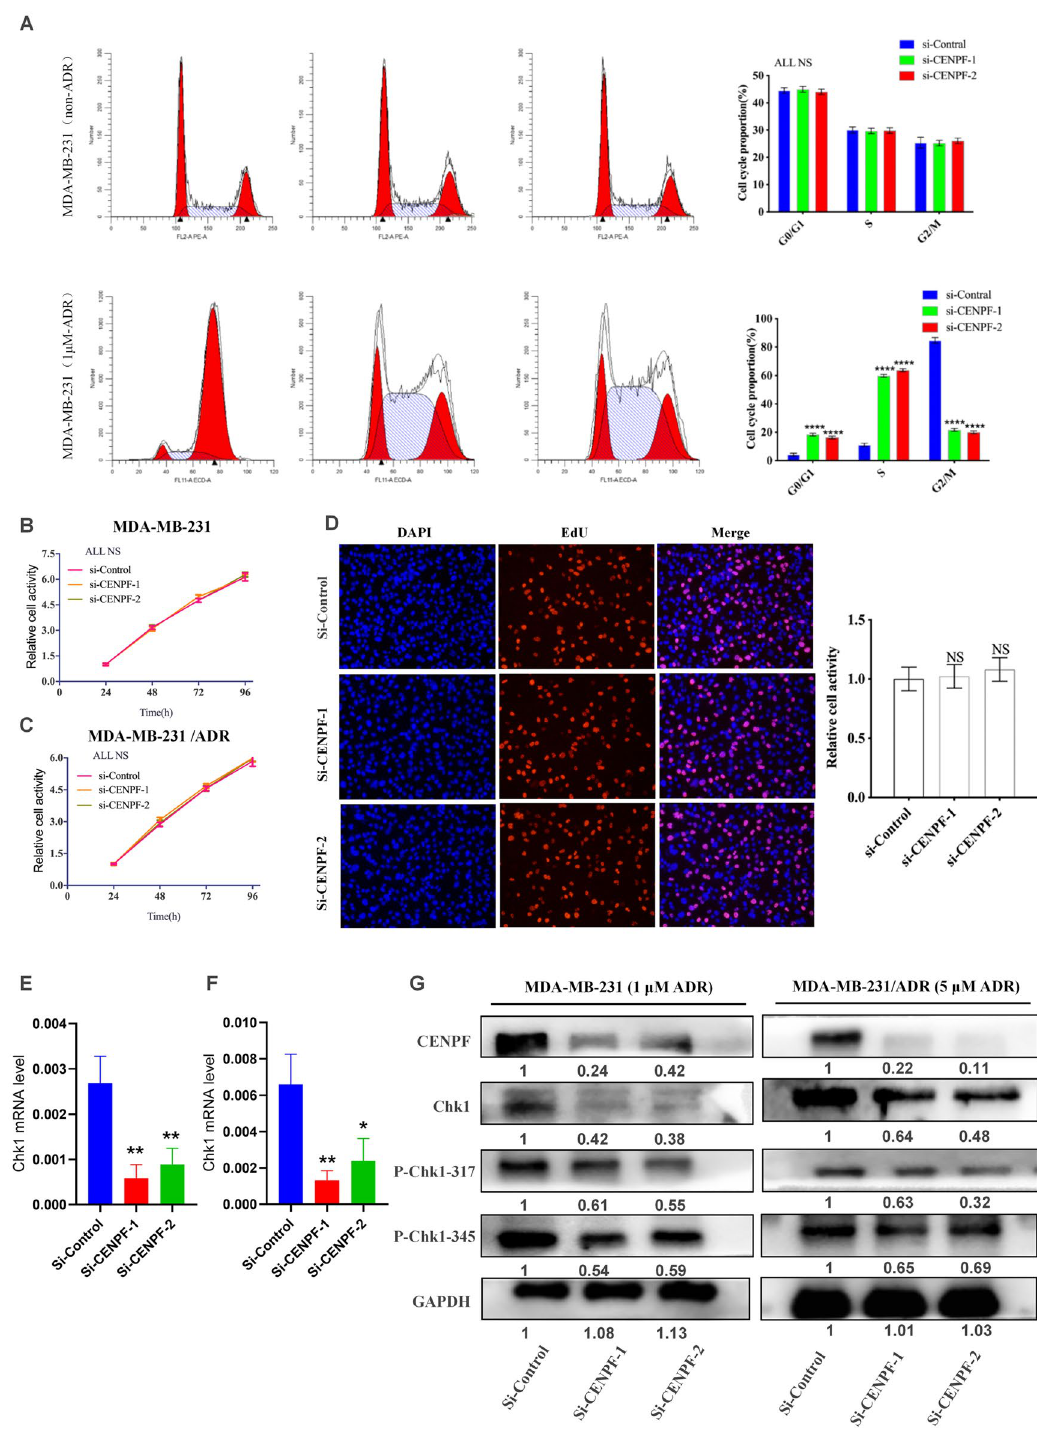
Figure 3. CENPF regulates ADR-induced G2/M phase arrest through Chk1. ( A ) Flow cytometry was performed to determine the effects of CENPF inhibition on cell cycle distribution with or without adriamycin in MDA-MB-231 cells. ( B , C ) The effect of CENPF inhibition on cell proliferation in MDA-MB-231 ( B ) or MDA-MB-231/ADR ( C ) cells. ( D ) Cell proliferation was determined by EdU assay. ( E , F ) Using RT ‒ qPCR, the mRNA level of CHK1 was detected in MDA-MB-231 ( E ) or MDA-MB-231/ADR ( F ) cells with CENPF knockdown. ( G ) Western blot analysis of the effect of CENPF knockdown on Chk1 expression and phosphorylation in MDA-MB-231 and MDA-MB-231/ADR cells exposed to adriamycin. Data shown represent the means (± SD) of three independent experiments; **P < 0.01, ****P < 0.0001; NS not significant; one-way ANOVA ( A – F